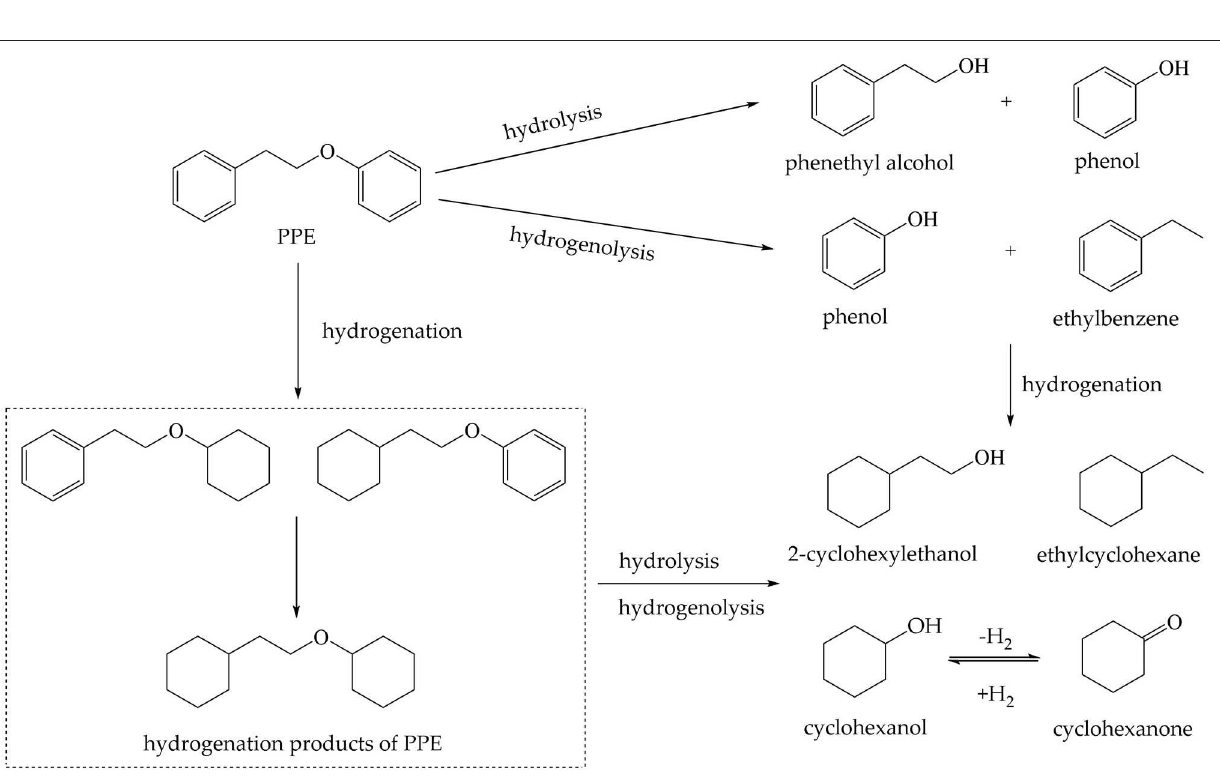
Frontiers in Energy Research |